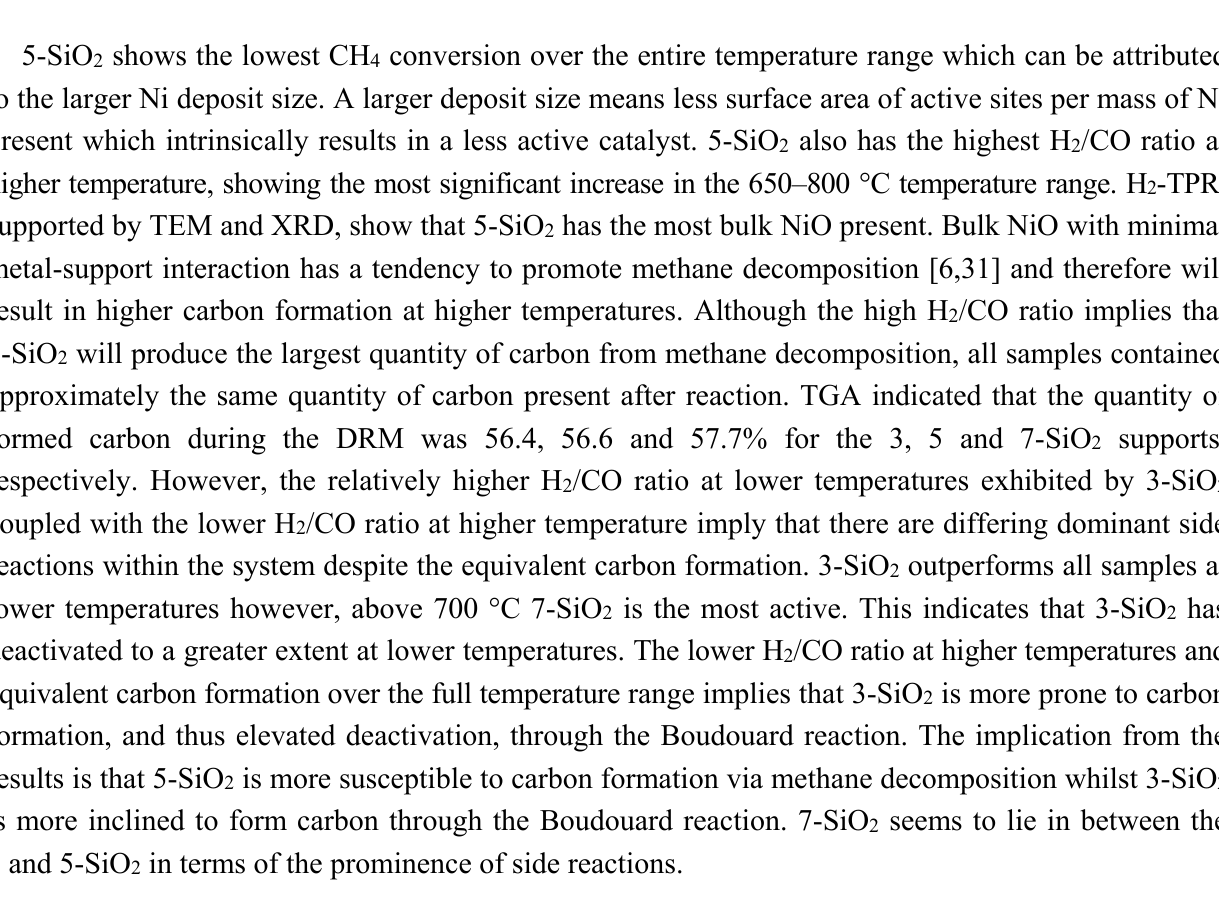
Figure 6. Methane light-off curves ( a ) and accompanying H 2 /CO production ratio ( b ) during dry reforming of methane over 5% Ni supported by 3, 5 and 7-SiO 2 . Conditions: WHSV = 144 L/(h·g cat ), catalyst loading = 0.025 g, N 2 /CH 4 /CO 2 =